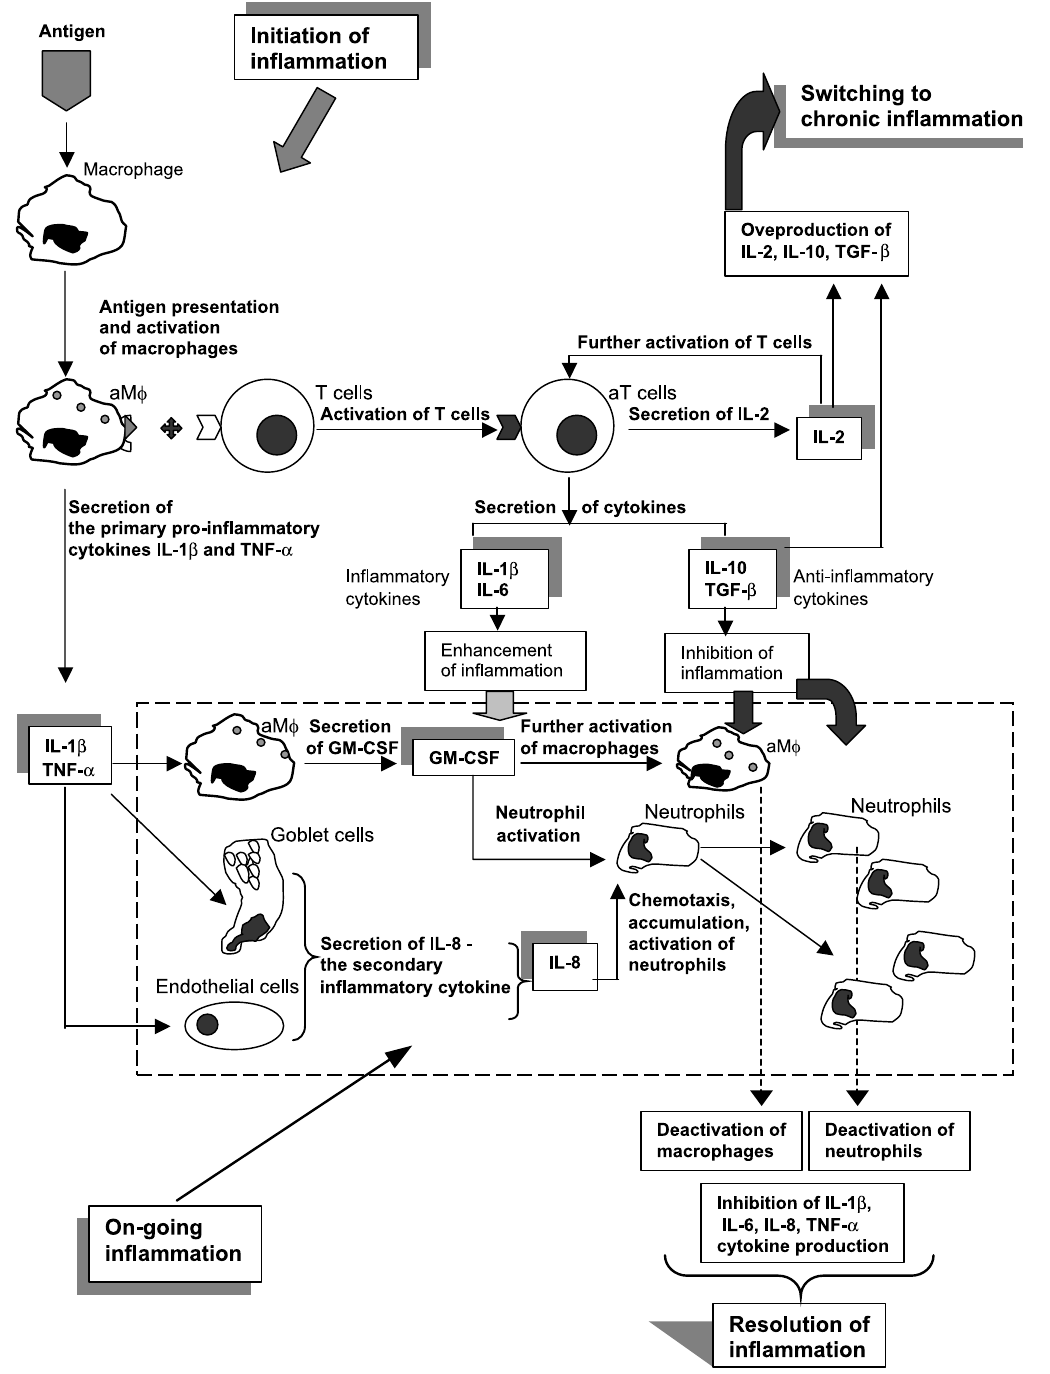
FIG. 2. Cytokine regulation of acute inflammatory response in the middle ear. Initiation of inflammation includes activation of macrophages, which, by presenting antigen, interact with T cells and induce the T-cell activation. The activated macrophages (aM f ) produce the primary pro-inflammatory cytokines IL-1 b and TNF- a , which up-regulate secretion of IL-8 by goblet cells and endothelial cells and secretion of GM-CSF by activated macrophages. IL-8 and GM-CSF promote activation of neutrophils and macrophages * / the main effector cells of acute inflammation. IL-8 induces chemotaxis and accumulation of neutrophils, and GM-CSF increases neutrophil phagocytosis and inflammatory activity of macrophages. Simultaneously the activated T cells (aTcells) produce many cytokines including IL-1 b , IL-6, IL-2, IL-10 and TGF- b . IL-2 enhances further activation and differentiation of T cells. IL-1 b and IL-6 join the ongoing inflammation and enhance it. IL-10 and TGF- b keep under control inflammatory processes, and when the antigen is completely destroyed they inhibit activities of neutrophils and macrophage and production of the inflammatory cytokines IL-1 b , IL-6, IL-8 and TNF- a , and thus provide resolution of inflammation. Overproduction of the immunoregulatory cytokines IL-2, IL-10 and TGF- b in the course of middle ear inflammation will promote humoral and cell-mediated chronic processes and switching of inflammation in the chronic stage.